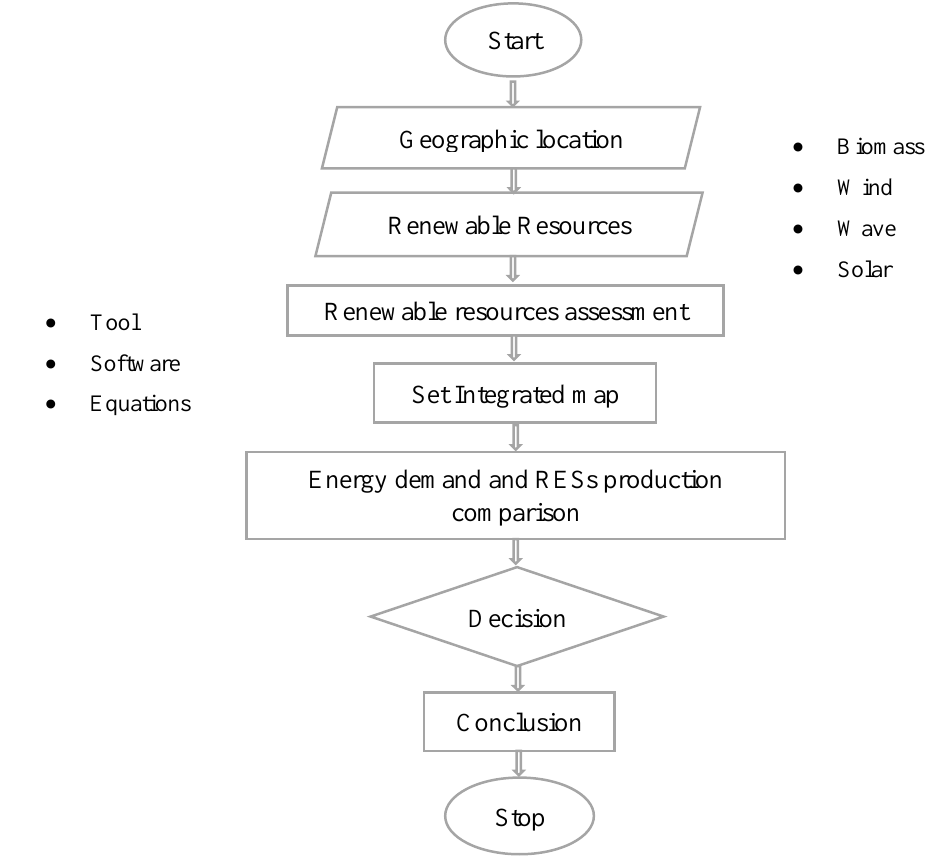
Figure 1. Architecture of renewable energy resources (RESs) estimation.